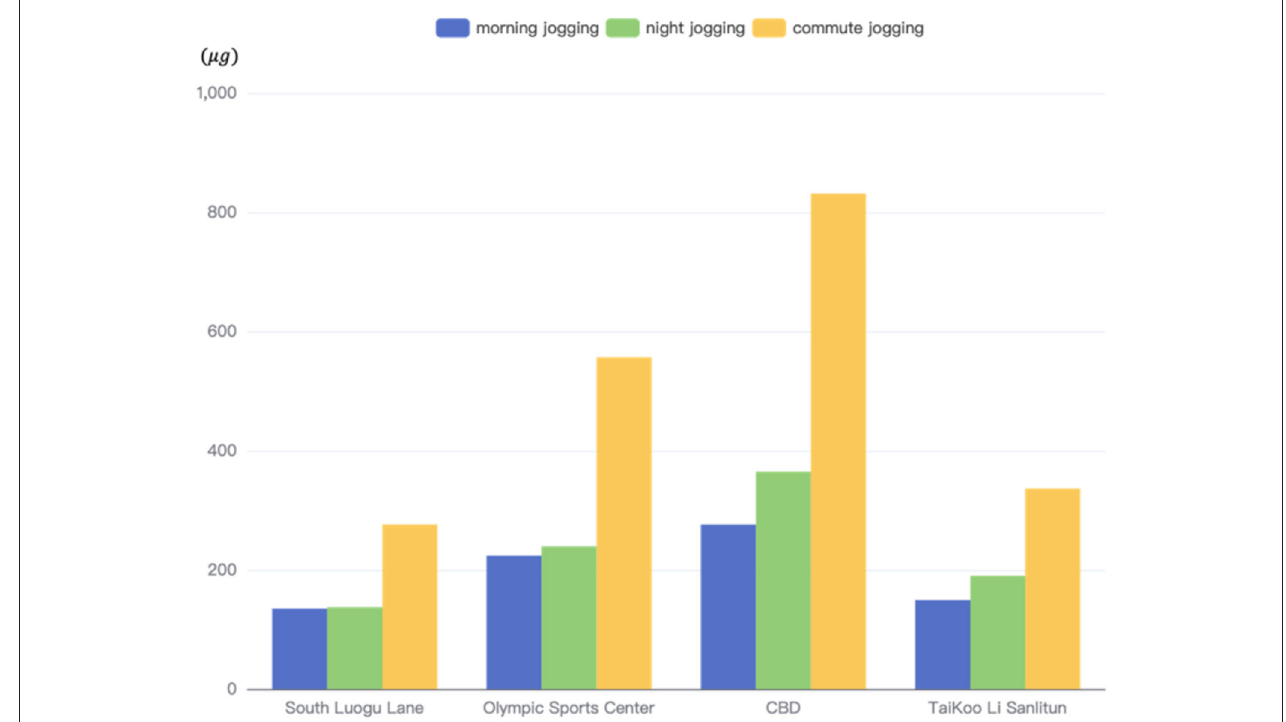
FIGURE 15 | PM2.5 inhalation caused by jogging on some typical roads in four regions.